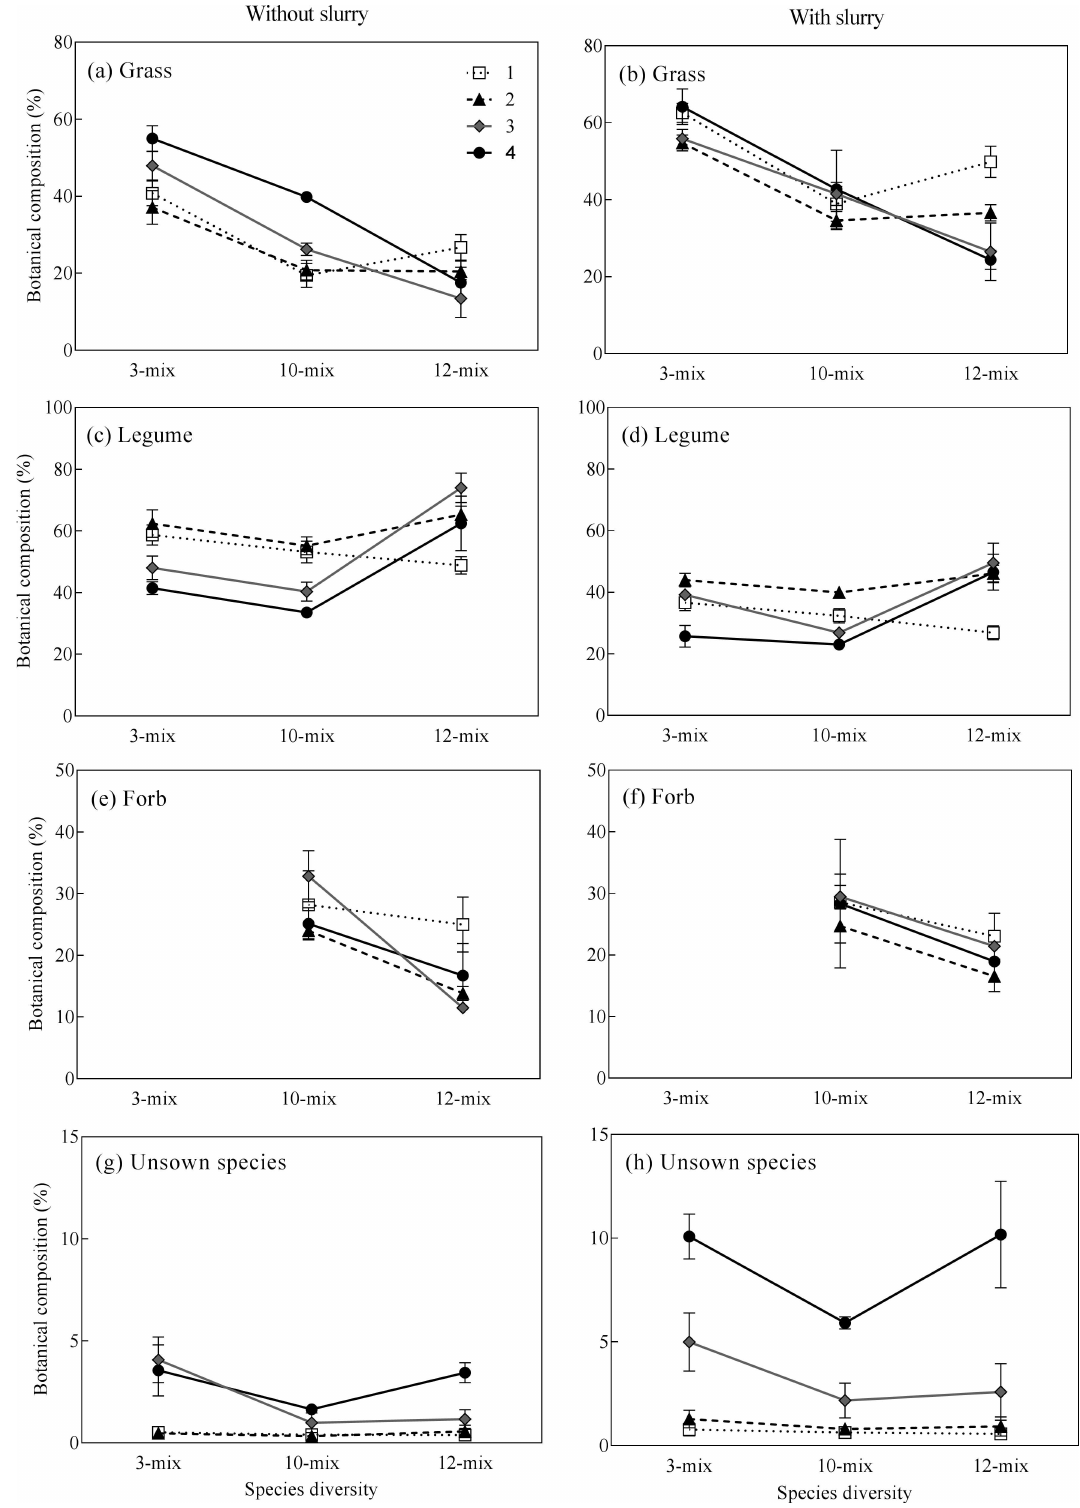
Fig 3. Botanical composition (% of DM) (mean ± SE) of different functional groups in three mixtures of 1- to 4-yr-old grasslands.